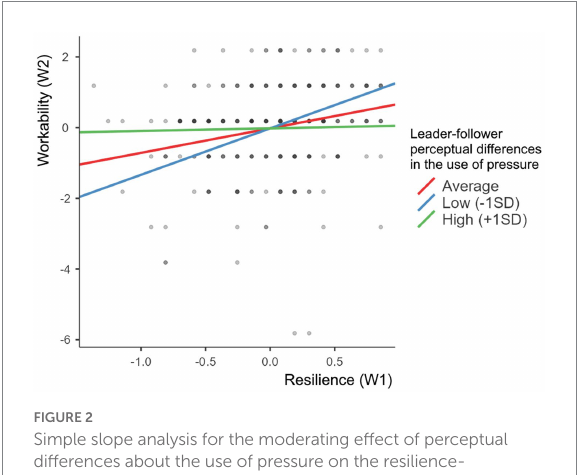
FIGURE 2 Simple slope analysis for the moderating effect of perceptual differences about the use of pressure on the resilience- workability